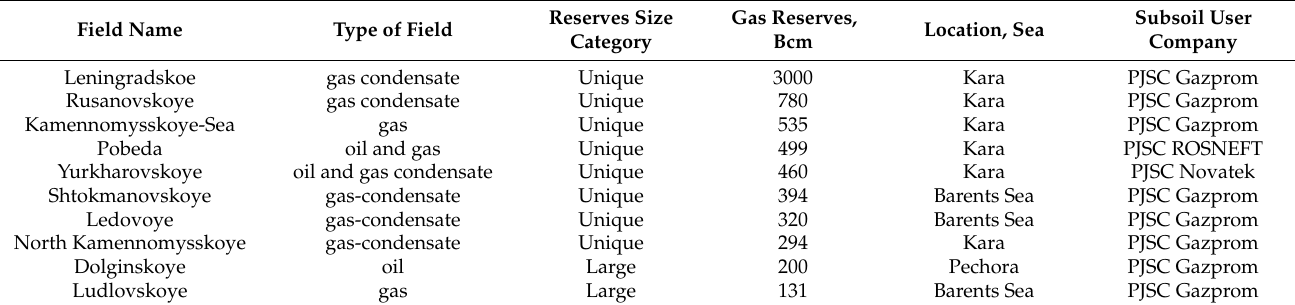
Table 1. Characteristics of the largest fields of the Russian Arctic shelf. Source: compiled from materials [51]. Field